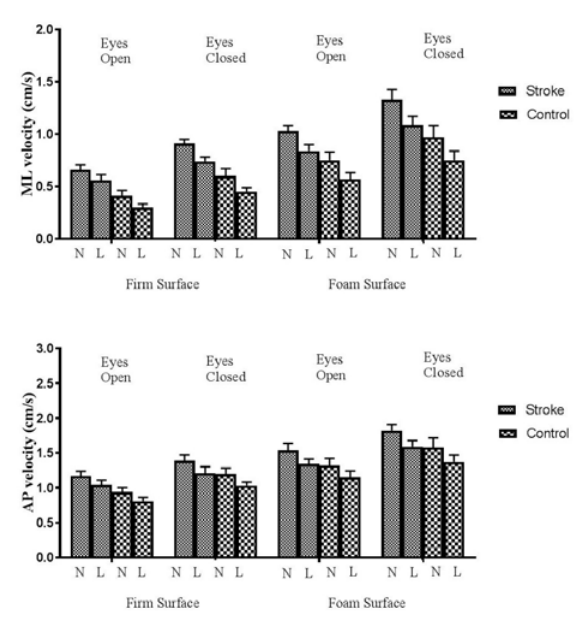
Figure 1: The mean velocity of center of pressure in the two groups for each condition. ML, medio-lateral; AP, antero-posterior; N, no touch; L, light touch.